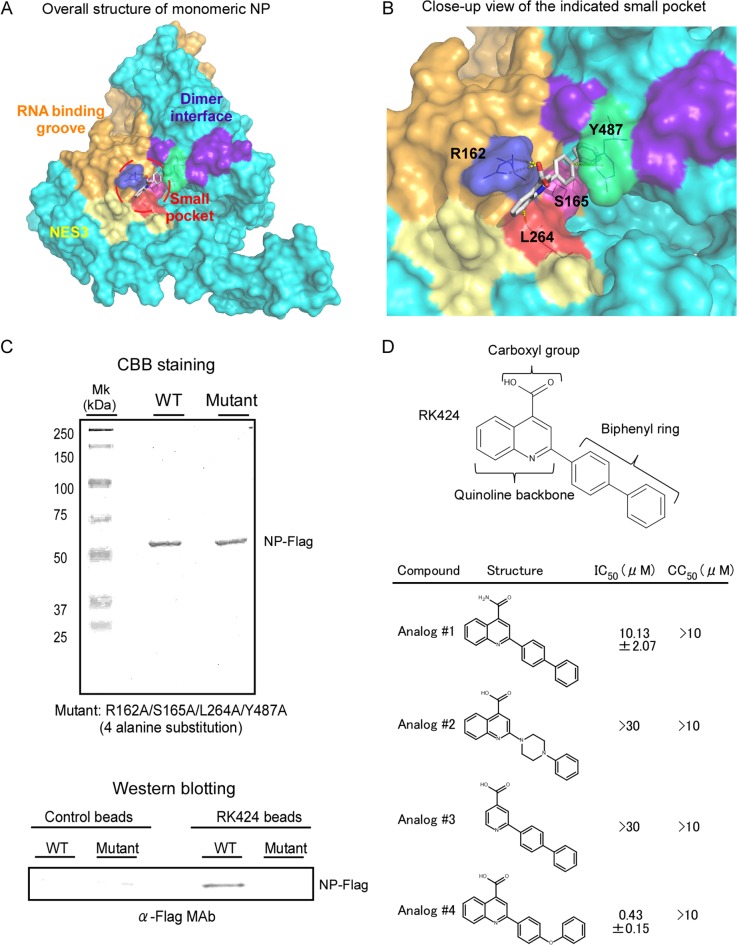
Model for potential binding of RK424 to NP.
In silico docking analysis was used to predict potential binding sites for RK424 on NP. The configuration with the highest binding energy was visualized using PyMol. (A) Crystal structure of NP. The nuclear export signal (NES) (yellow: amino acid (aa) 256–266), RNA binding grove (orange: aa 1–180), and dimer interface (purple: aa 482–489) are shown on the surface representation. The small pocket is highlighted by red circles. (B) Close-up of the NP small pocket. An electrostatic surface representation of the potential binding site on NP. Amino acids are colored blue (R162), pink (S165), red (L264), and green (Y487). (C) Purified wild-type NP-Flag (WT) and purified mutant NP-Flag (Mut) proteins harboring alanine substitutions at all four potential binding sites (162 165, 264, and 487) were added to RK424 cross-linked affinity beads or uncross-linked beads. Isolated NP-Flag (WT) and mutant NP-Flag (Mut) proteins were run in 10% SDS-PAGE gels and purity was checked by Coomassie Brilliant Blue (CBB) staining (upper panel). The binding of NP to RK424 beads was detected by western blotting with an anti-Flag MAb (lower panel). The positions of the NP-Flag proteins are indicated. Three independent experiments were performed and one representative result is shown. (D) Structure-activity relationship (SAR) analysis of RK424. The in vitro antiviral activity (IC50) and cell toxicity (CC50) of four different structural compounds derived from RK424 were evaluated in a plaque assay and in a WST-1 assay based on MDCK cells. Data are expressed as the mean ± SD of three samples in each of three independent experiments.